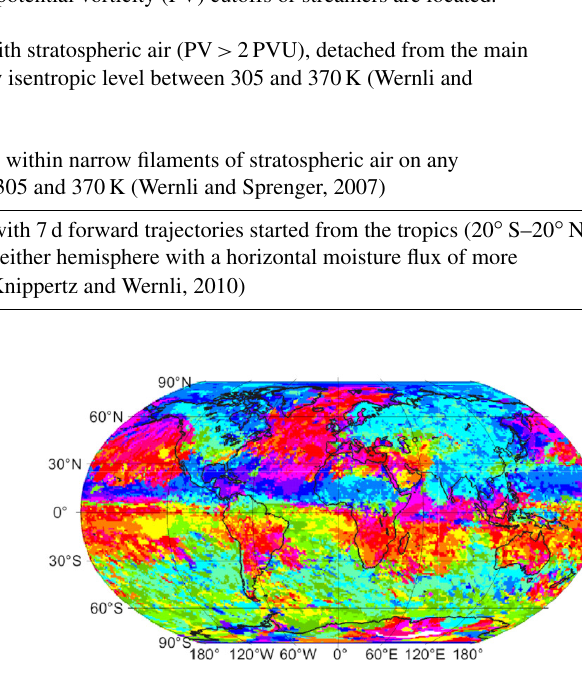
Figure 3. Month during which the central day of the primary ex- treme season occurred at each grid